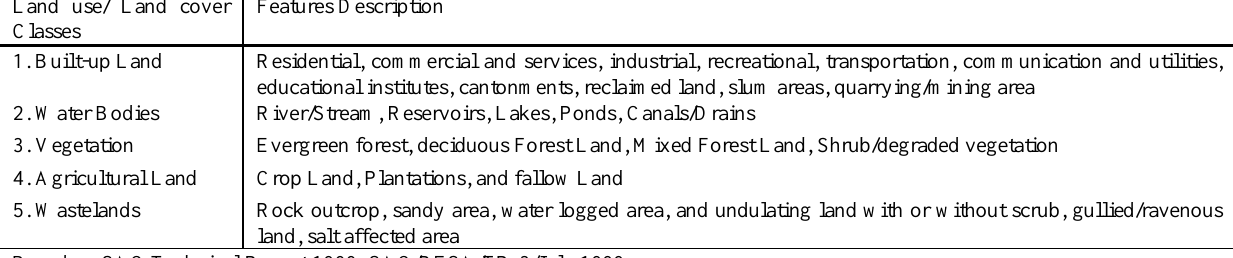
Table 1. Land use / Land cover classification schema used in the